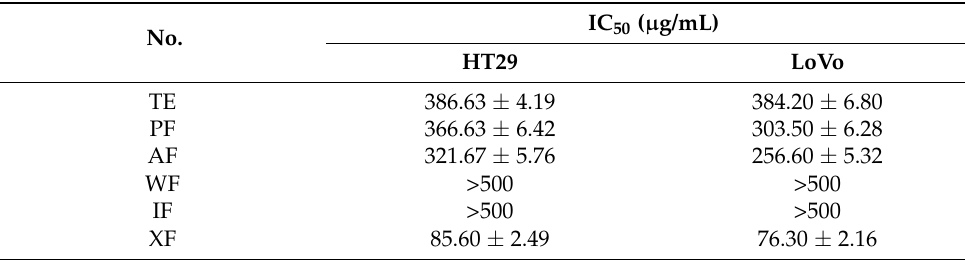
Table 1. IC 50 values of component groups obtained from GA on HT29 and LoVo